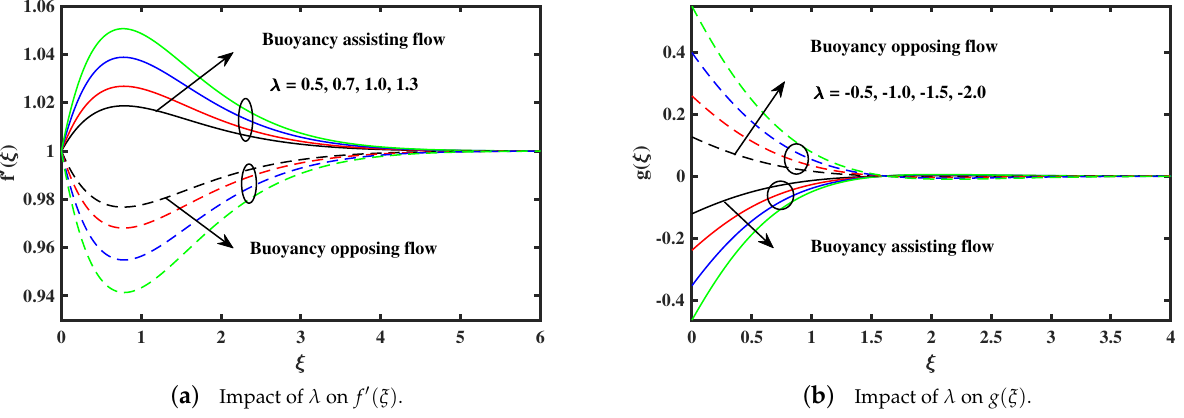
Figure 4. Fluctuation of f (cid:48) ( ξ ) and g ( ξ ) against thermal buoyancy ( λ